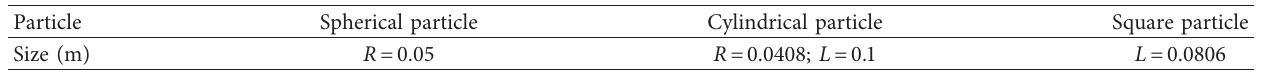
Table 1: Impact parameters of the coal-rock